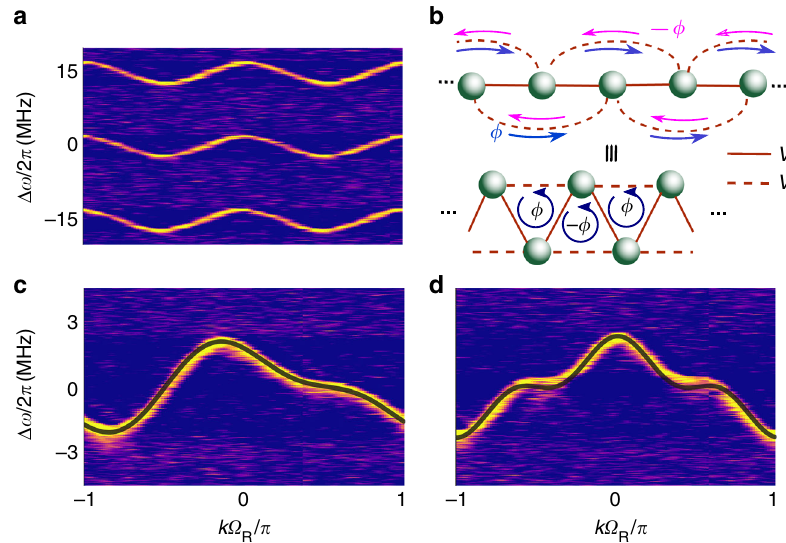
Fig. 4 Band-structure engineering with long-range hopping and synthetic gauge potentials. a Time-resolved transmission for a modulation frequency Ω M = 2 Ω R , coupling exclusively next-nearest neighbors. While the band structure is similar to Fig. 3, the fi rst Brillouin zone is halved, and two periods of the cosine band structure are seen in Ω R t ∈ [ − π , π ]. b Schematic of lattice for V M = V 1 cos Ω R t + V 2 cos ( n Ω R t + ϕ ), where V 1 (solid lines) determines the strength of nearest-neighbor coupling and V 2 (dashed lines) determines the long-range hopping, here shown for n = 2. The phase of the V 2 links is + ϕ when going up in frequency and − ϕ when going down in frequency, as imposed by the modulation 53,54 . Bottom: Equivalent lattice representation by a triangular chain threaded by a phase ϕ per plaquette. c Measured nonreciprocal band structure for V 2 / V 1 = 0.40, ϕ = π /2, n = 2, which shows strong asymmetry about k = 0. See also Supplementary Movie 2. d Same as c , but for ϕ = 0, n = 3. Black overlays in ( c ) and ( d ) indicate expected band